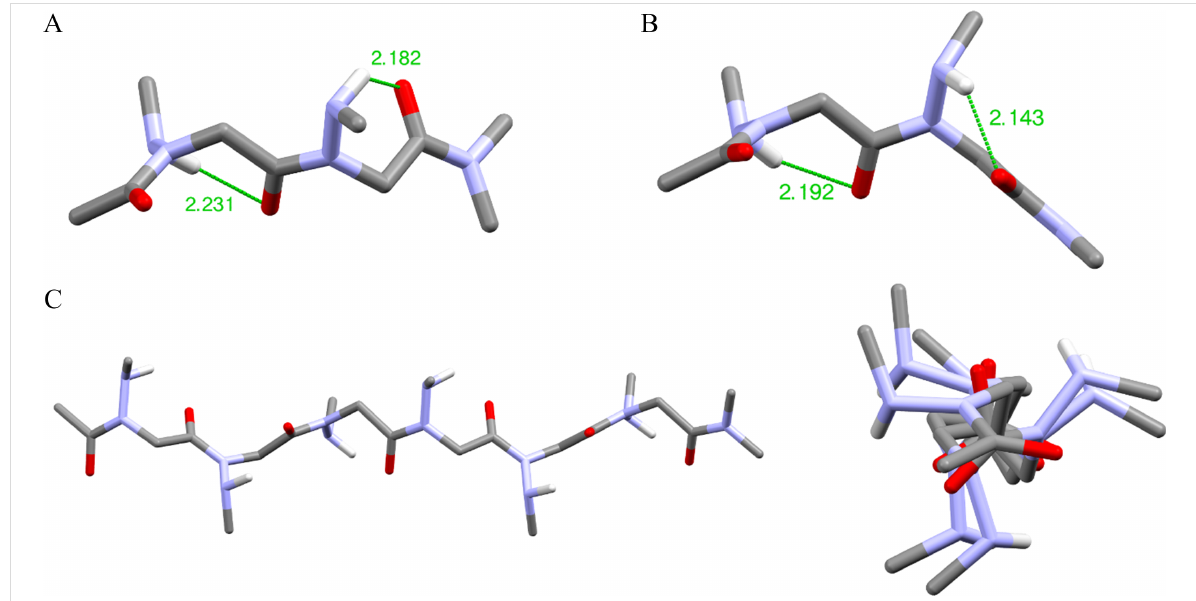
Figure 6: Model structure of N -(NMe)glycine peptoid. (A) dimer in the repeating (pp) conformation; (B) dimer in the alternating (pm) conformation; (C) hexamer in the repeating (p) 6 conformation: side view (left), perpendicular to helix axis